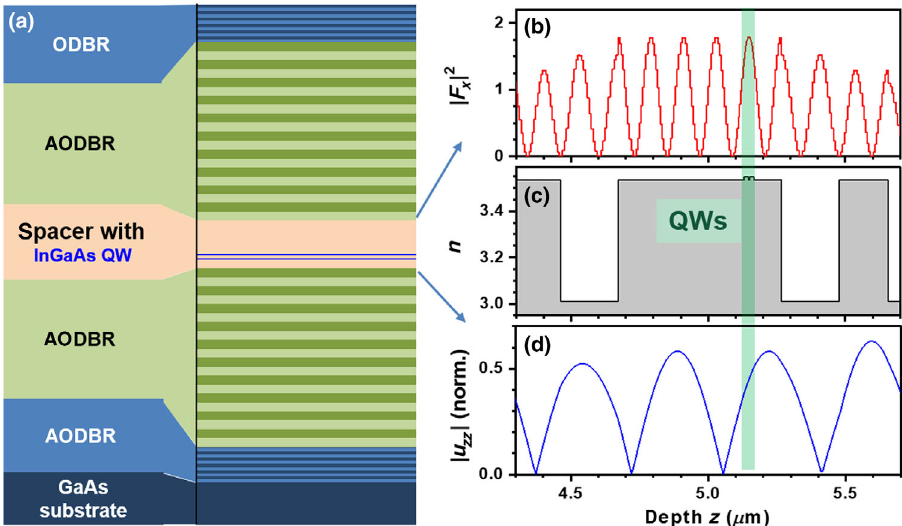
FIG. 8. (a) Layer structure of the hybrid microcavity (sample A ). Depth profiles within the spacer region of the hybrid microcavity of the (b) optical field F at the photonic resonance energy, where x is the polarization direction on the MC surface, (c) refractive index, n , and x ¼ 6 . 9 (d)normalizedacousticstrainfield u fortheacousticresonancefrequency f zz MC